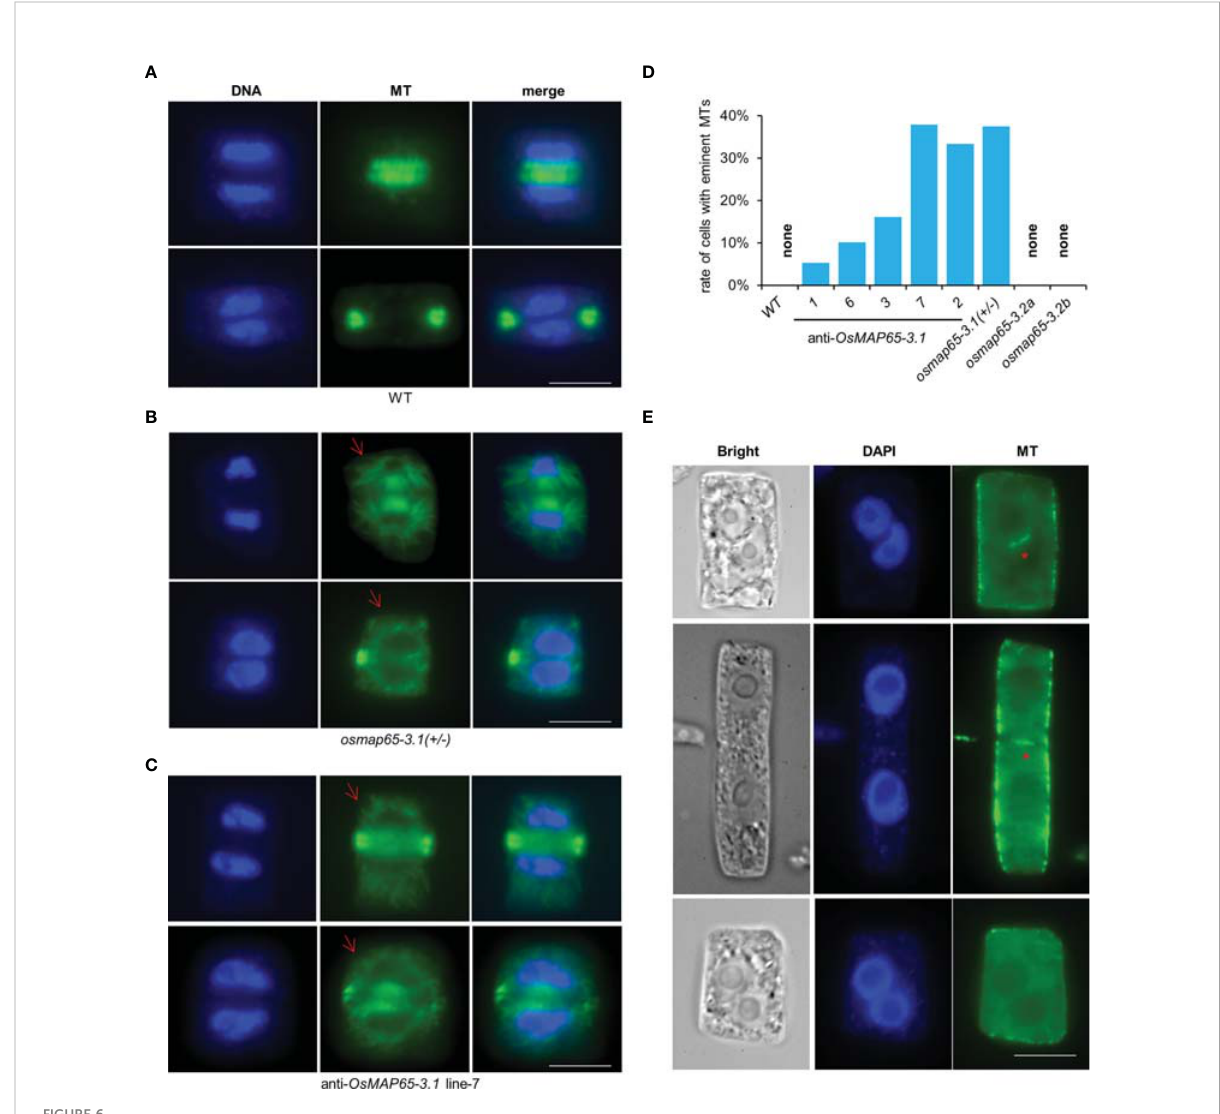
FIGURE 6 The developing phragmoplasts and cytokinesis in root apical meristematic cells of osmpa65-3 defect plants. (A) Wild-type cells in cytokinesis. (B, C) Cells of osmap65-3.1(+/-) (B) and anti-sense OsMAP65-3.1 line-7 (C) in cytokinesis. Eminent MTs emanated from the surface of the reforming daughter nuclei (the red arrows) were frequently observed. (D) The percentage of cells with eminent MTs radiating from daughter nuclei in wild-type, anti-sense OsMAP65-3.1 lines, osmap65-3.1(+/-) and osmap65-3.2 . (E) The cytokinesis failures in osmpa65-3.1 defect plants. The new cell plates cannot be formed at all or be partially generated (the red stars) in these cells. Bar = 10 um (A-C, E)